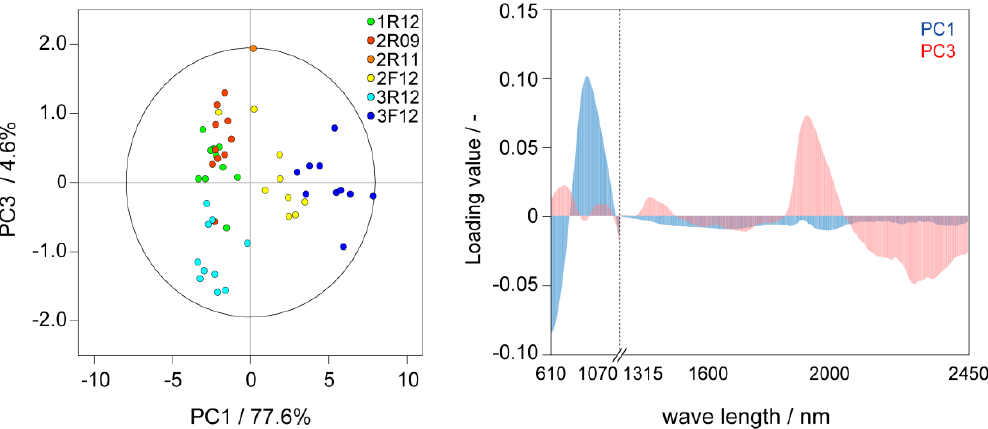
Figure 1. PCA of NIR spectra for the non-invasive characterization of seeds. ( a ) Score plots (PC1 vs. PC3) in PCA for NIR spectra (See also Figure S1). An ellipse in score plot was represented the Hotelling’s T2 95% confidence. An outlier was removed before (See Figure S2); ( b ) Loading plots (PC1 vs. PC3) in PCA. Input-data were generated from two different wavelength NIR spectra. Two spectra were combined after normalization. 10 seeds of 6 each different sample except for 2R12 were used for